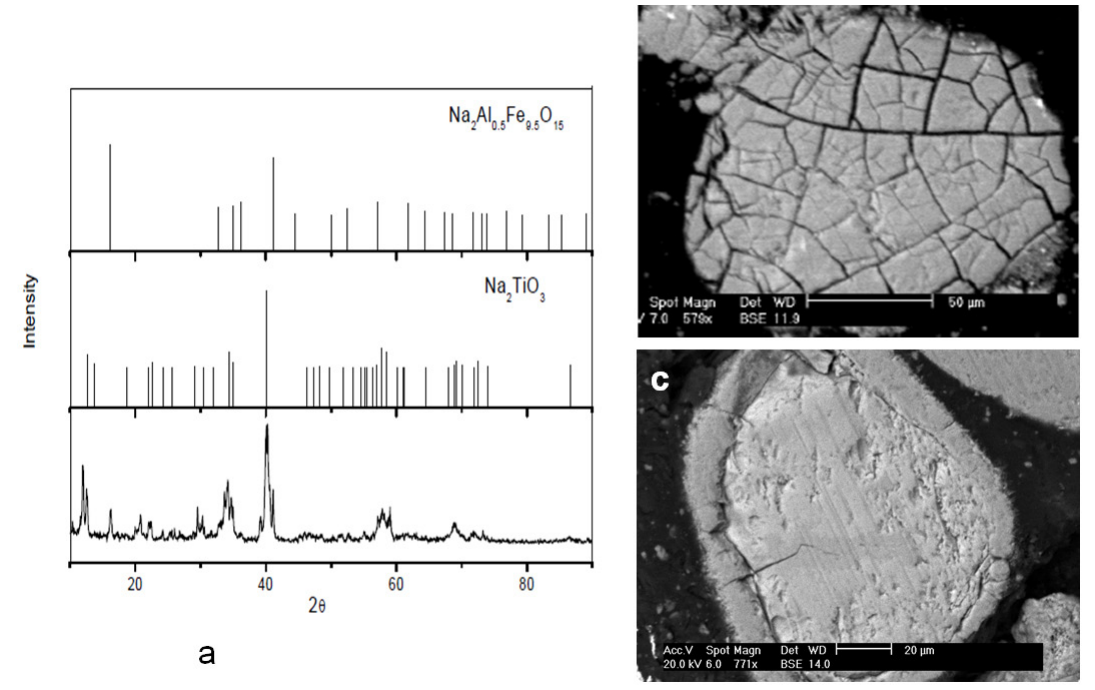
CO ; (b) backscattered image of ilmenite roasted with NaOH at 400 o C; 2 3 CO at 900 o 2 3